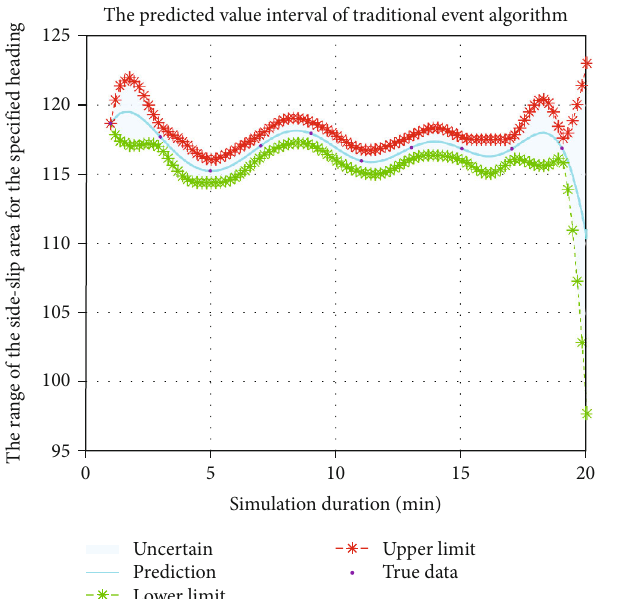
Figure 11: Forecast points and forecast intervals based on the improved event